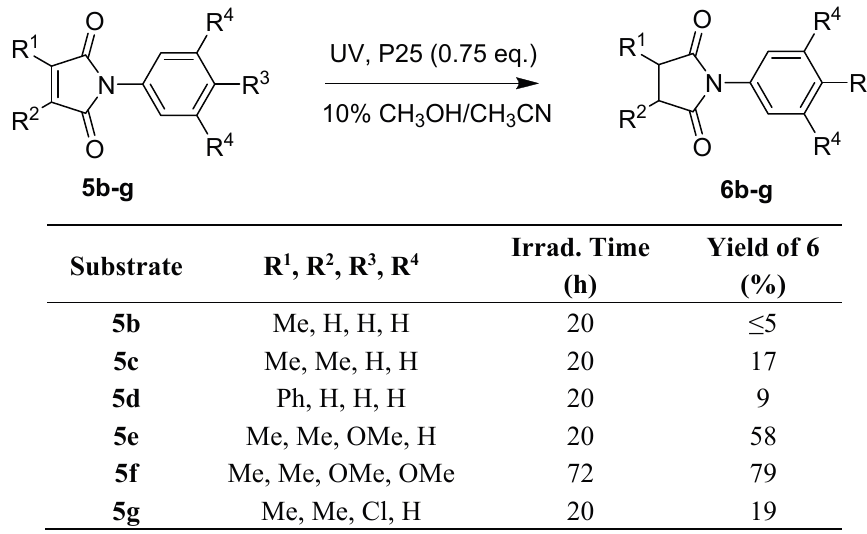
1. Titania semiconductor photoredox catalysis (SCPC) hydrogenations of substituted maleimides a